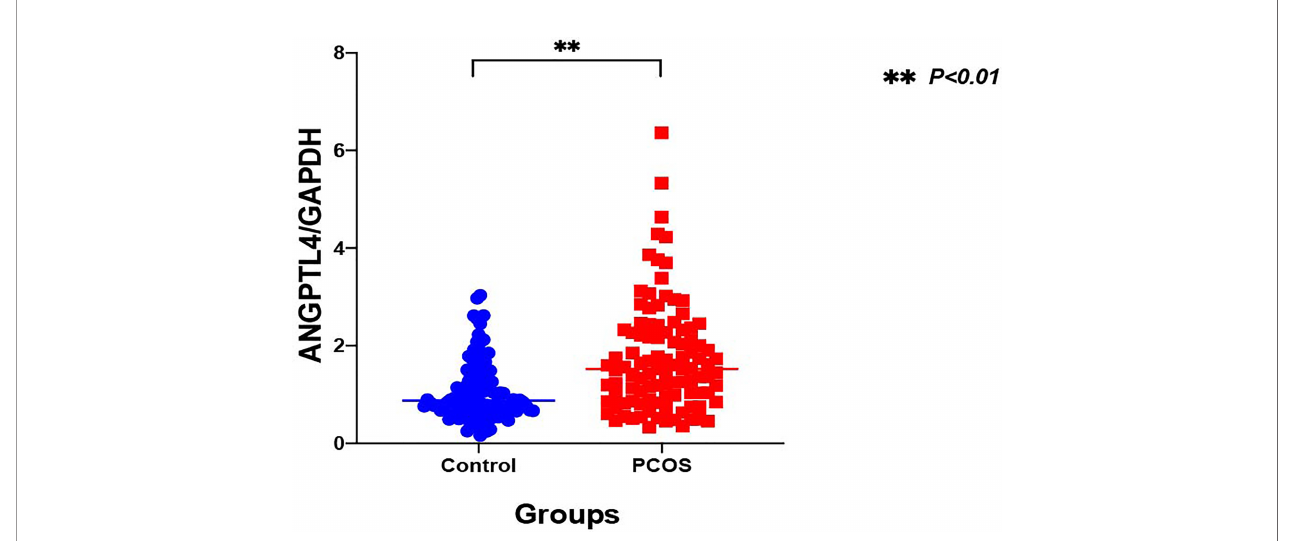
FIGURE 1 | The relative expression of ANGPTL4 in ovarian granulosa cells of PCOS and control patients (**p < 0.001). Data were normalized to GAPDH.